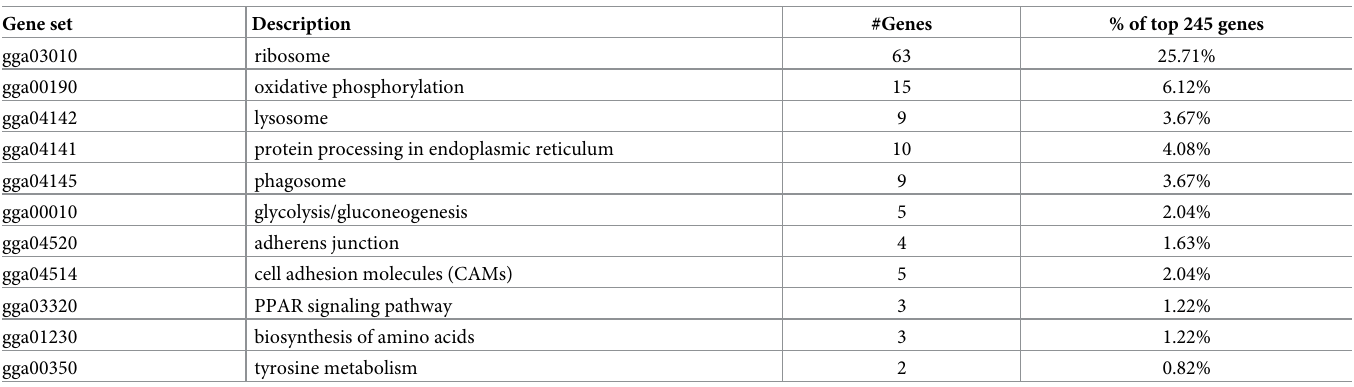
Table 3. KEGG pathway analysis for the overall top 245 highly expressed genes # . Gene